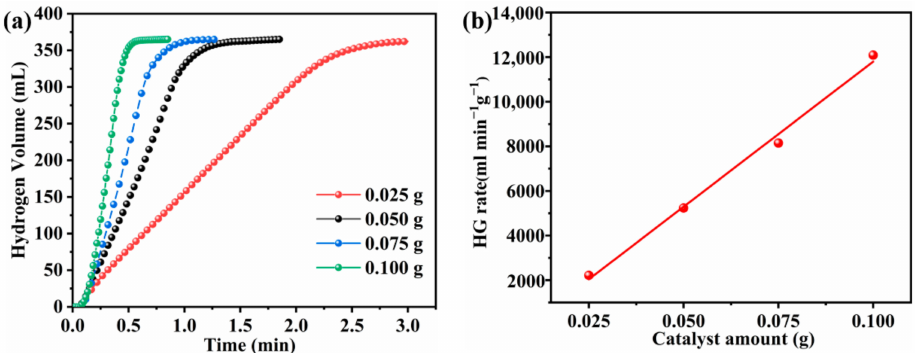
Figure 9. ( a ) Effect of catalyst loadings on the HG rate (batch system, 25 ◦ C, 1.5 wt% NaBH 4 + 5 wt% NaOH); ( b ) HG rate versus catalyst dosage.